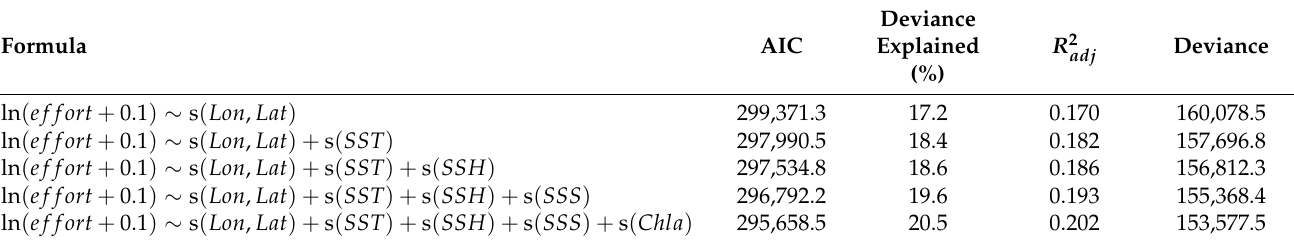
Table 3. Statistical parameters of GAM model (0.1 ◦ × 0.1 ◦ ).